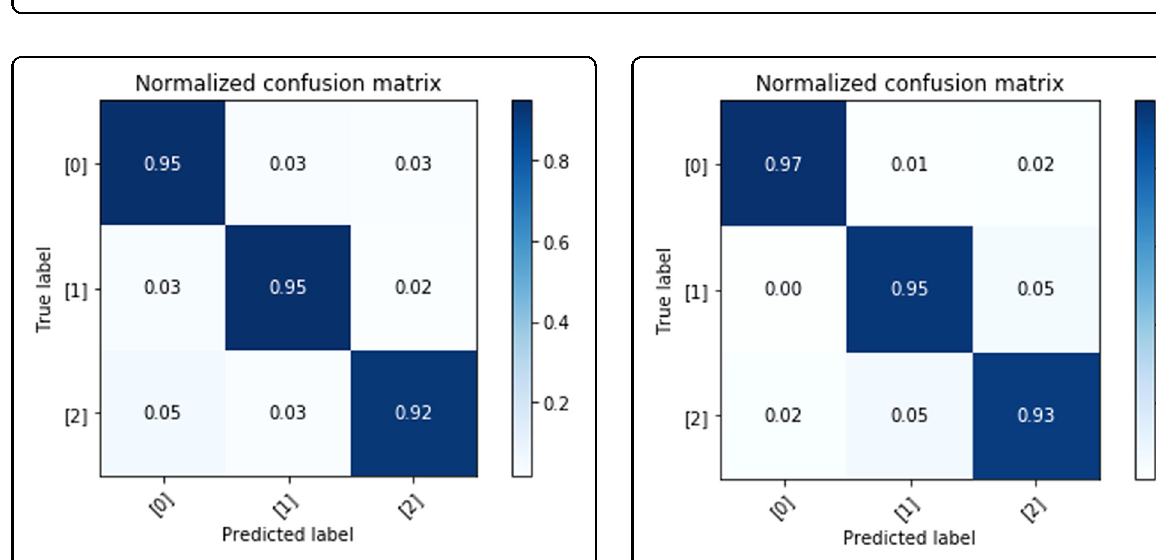
Fig. 2 Overview of developed model for objective evaluation of mental health status. Three different networks with the same architecture are trained to evaluate HHI, STAI, and WEMWBS metrics. The HHI, STAI, and WEMWBS are metrics used for subjective evaluation of hope, stress/anxiety, and mental well-being, respectively. Blocked data through visual metrics time series were used as input to the CNN-LSTM model. In this study, sliding window length ‘ L ’ is 51 and 20 visual metrics are considered as dimension of input to the network. The output of the model is level of mental well- being (evaluated by WEMWBS metric), anxiety/stress (evaluated by STAI metric and hope (evaluated by HHI metric) based on three categories of low (class label: 0), intermediate (class label: 1), and high (class label: 2) categories.